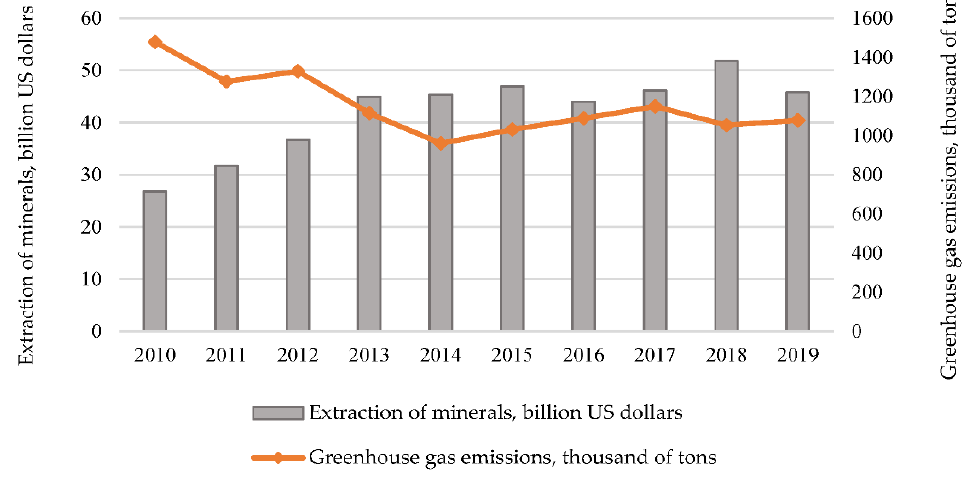
Figure 1. Changes in resource extraction and greenhouse gas emissions in the Russian Arctic. Source: created by the authors, data from [81,82].